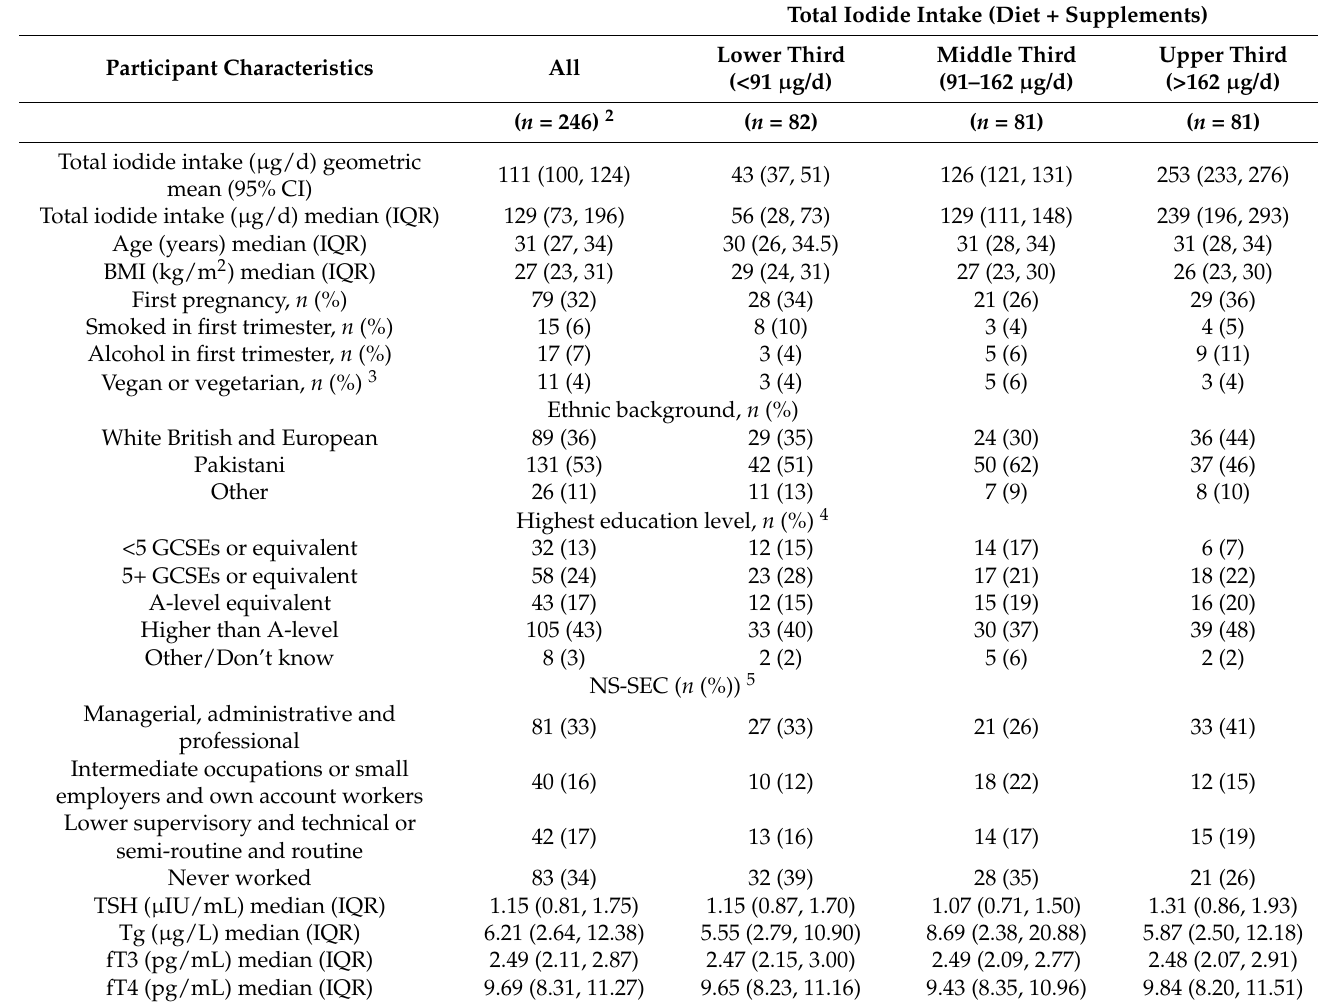
Table 1. Maternal characteristics by category of total iodide intake at first appointment 1